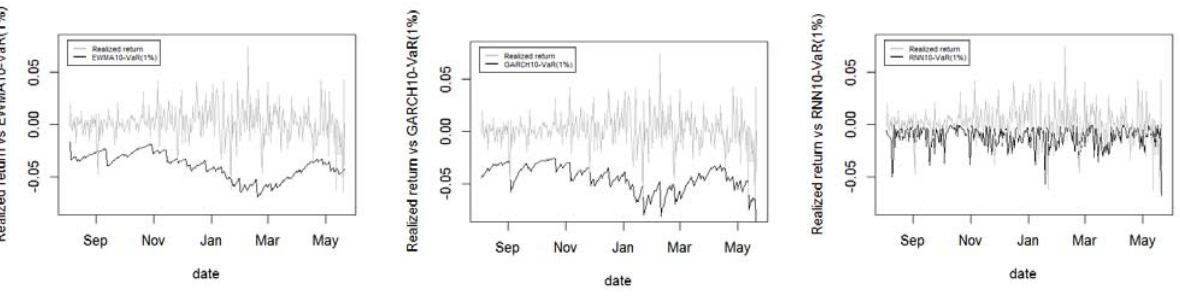
Figure 5. Out of sample realized return vs 5 days ahead VaR(1%) of EWMA, GARCH and RNN model